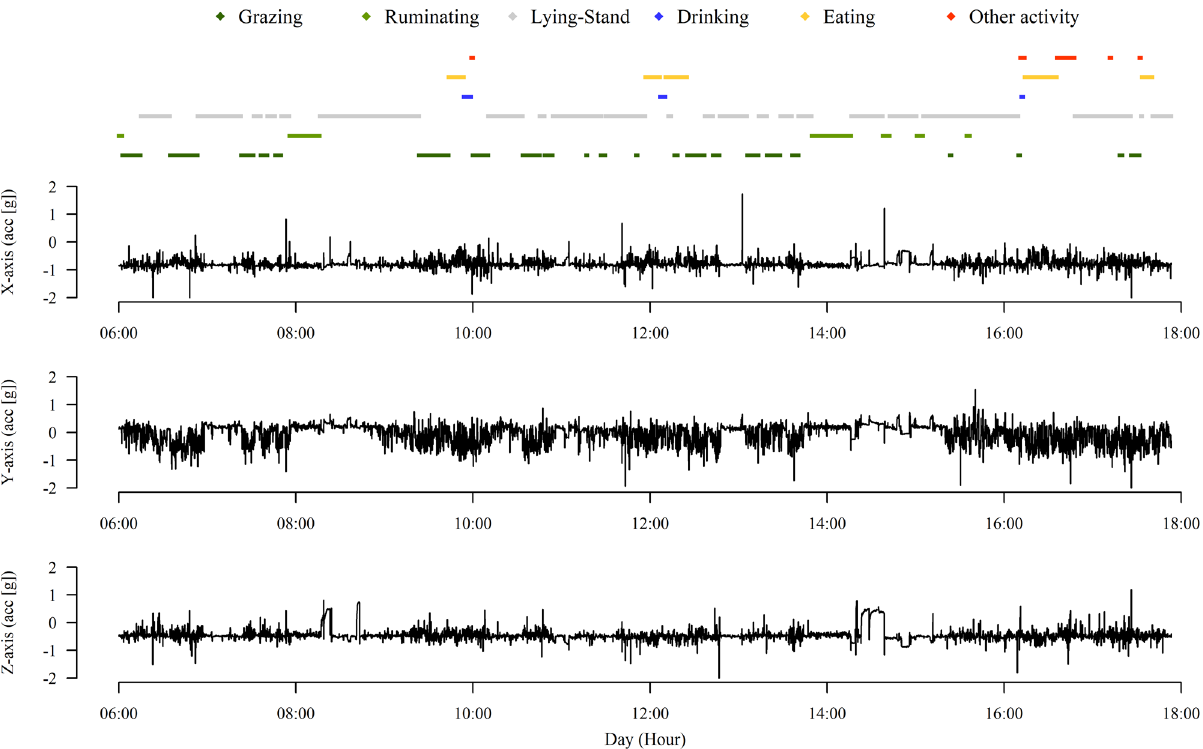
Figure 1. Pattern of records from the X-axis, Y-axis and Z-axis for each type of animal behavior observed (grazing, ruminating, lying-standing a , drinking, eating and other activities), from monitoring one animal in this study. ( a Lying-standing: activities of lying down + standing